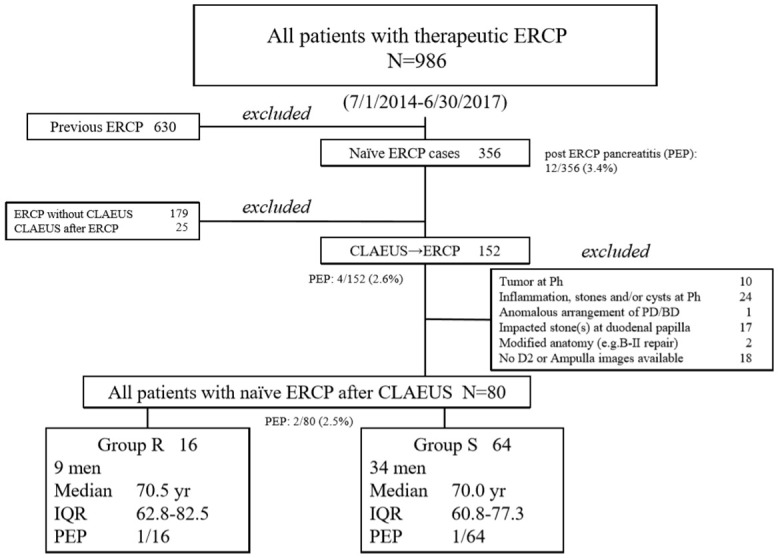
Flow diagram of patient recruitment.aCLAEUS, curved linear array endoscopic ultrasound; bERCP, endoscopic retrograde cholangiopancreatography; cIQR, interquartile range. dPh, pancreatic head. ePD, pancreatic duct. fBD, bile duct. hB-II, Billroth-II reconstruction. iD2, 2nd portion of duodenum.